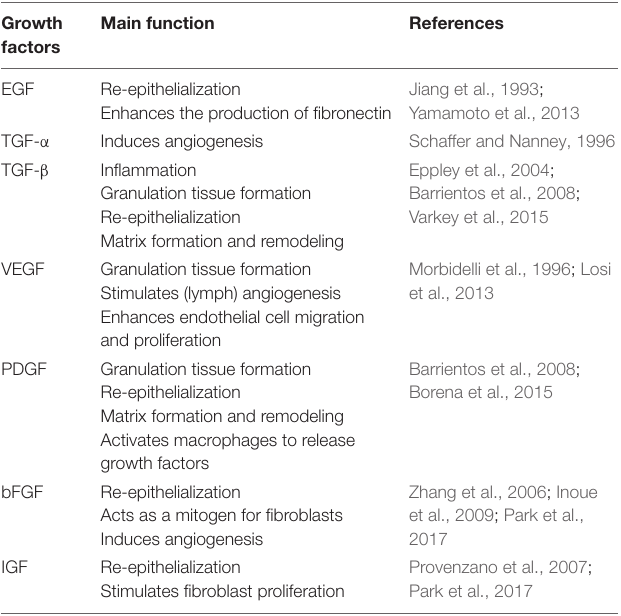
TABLE 2 | The role of growth factors in cutaneous wound healing.